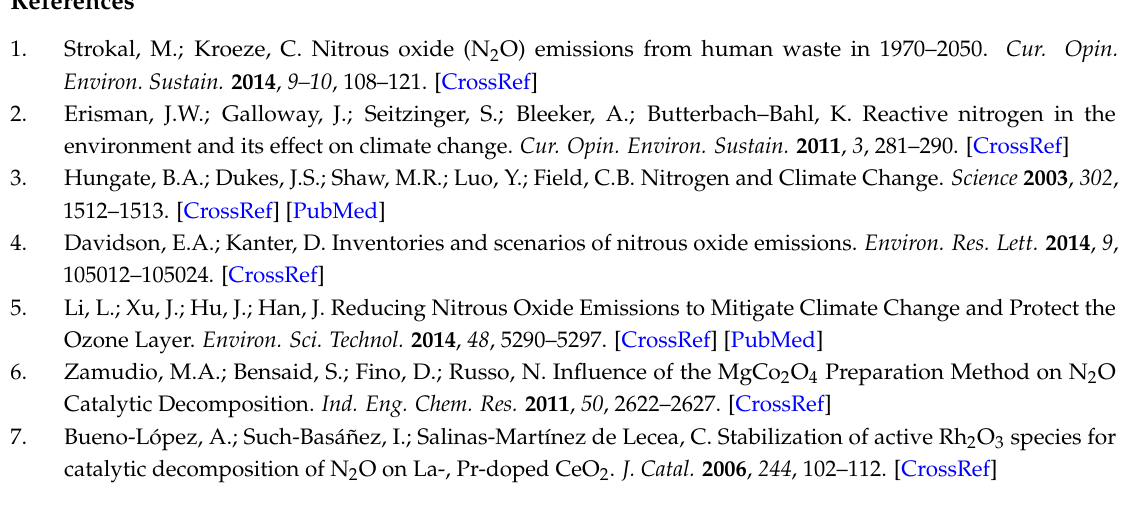
Figure 7. Stability test run of the Cu–Zn/ γ –Al 2 O 3 catalysts at 601 °C for 100 h.